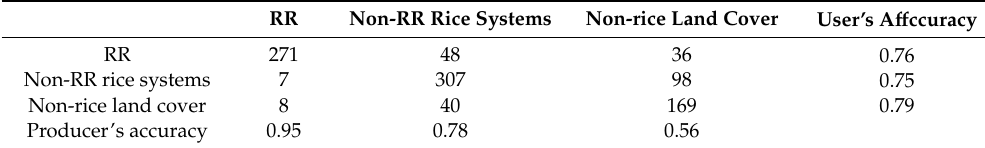
Figure 5. Predicted rice planting area of 17 prefecture-level cities compared against the rice area from the Hubei Rural Statistical Yearbook. Table 2. Confusion matrix of ratoon rice (RR), non-RR rice systems, and non-rice land cover types based on the reference data.